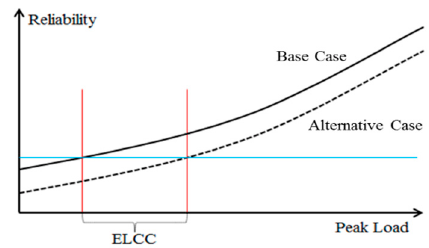
Figure 8. Concept of effective load carrying capability (ELCC).